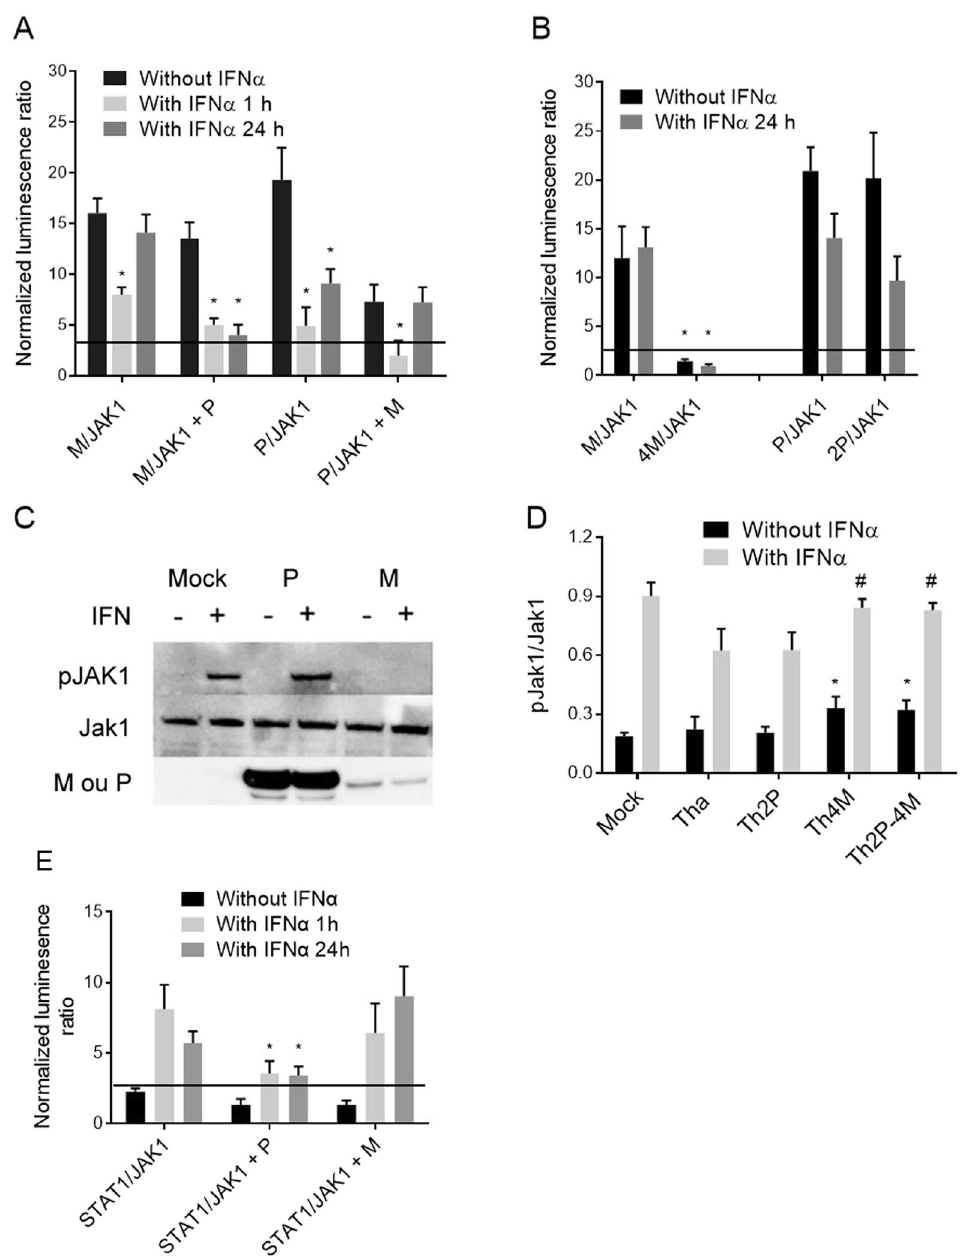
Figure 5. RABV M protein inhibited Jak1 activation and P protein blocked Jak1-Stat1 interaction. Protein complementation assay: wild-type ( A ) or mutated M (Th4M) or P (Th2P) protein ( B ) was co-transfected with JAK1-protein–coding plasmids and stimulated for 1 or 24 h with IFN α or not. Two days post-transfection, the Gaussia luciferase activity, whose intensity corresponds to interaction, was determined. P and M proteins were also transfected as third partners in some experiments. The bold horizontal lines represent Gaussia significance threshold. Results are expressed as means ± standard deviation (T-bars) of at least four independent experiments. * p < 0.05 compared to unstimulated samples. ( C ) Phosphorylated JAK1 protein (pJAK1), JAK1, and P and M proteins were detected by immunoblotting of cell lysates with specific antibodies. HeLa cells were transfected with wild-type P or M-proteins and stimulated ( + ) with IFN α (1000 U/mL, 24 h) or not ( − ). ( D ) pJAK1 ELISA was run on HeLa cells infected with RABV wild-type (Tha) or P- and/or M-mutated proteins (Th2P, Th4M, Th2P-4M) and stimulated or without IFN α . * p < 0.05 compared to Tha-infected samples not stimulated by IFN α and # p < 0.05 compared to IFN α -stimulated Tha-infected samples. Protein complementation assay ( E ): STAT1 and JAK1 proteins were co-transfected and stimulated for 1 or 24 h with IFN α or not. P and M proteins were also co-transfected as third partners in some experiments. Two days post- transfection, Gaussia luciferase activity, whose intensity corresponds to interaction, was determined. The bold horizontal lines represent Gaussia significance threshold. Results are expressed as means ± standard deviation (T-bars) of at least four independent experiments. * p < 0.05 compared to the corresponding data for STAT1/ JAK1